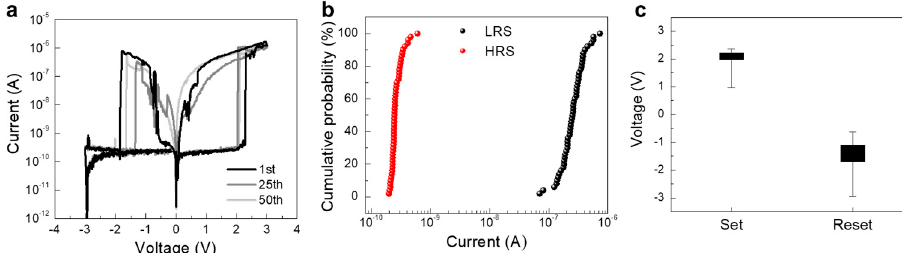
Figure 3. ( a ) I-V characteristics of CdSe/ZnS QD-PMMA memristors during a cyclic test (50 cycles) (QD: 1 wt%). ( b ) The variation of LRS and HRS currents during the cyclic test. ( c ) The distribution of set and reset voltages during the cyclic test.